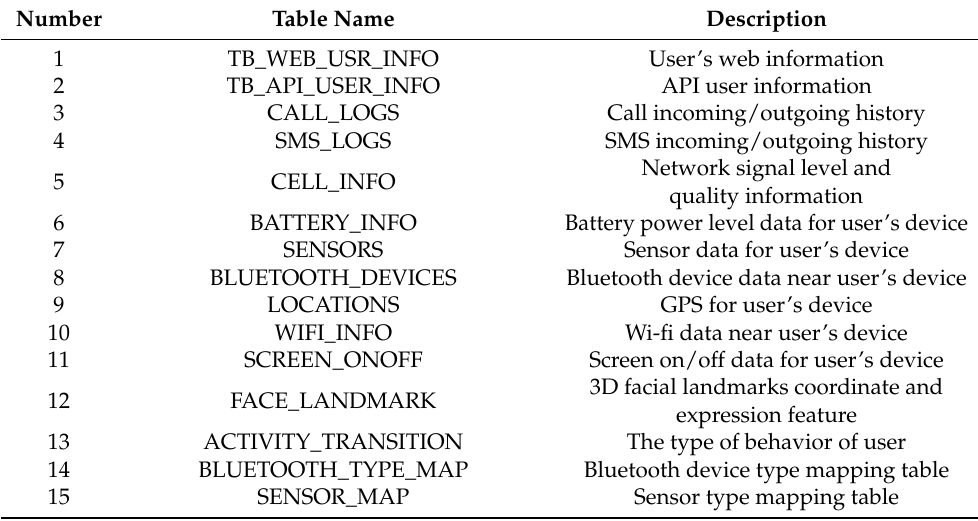
Table 1. Data table list collected from “Mental Health Protector” application. Multimodal sensor data collected for each user are transmitted to a cloud-based big data platform according to a predefined table. Data information about table names can be found in the